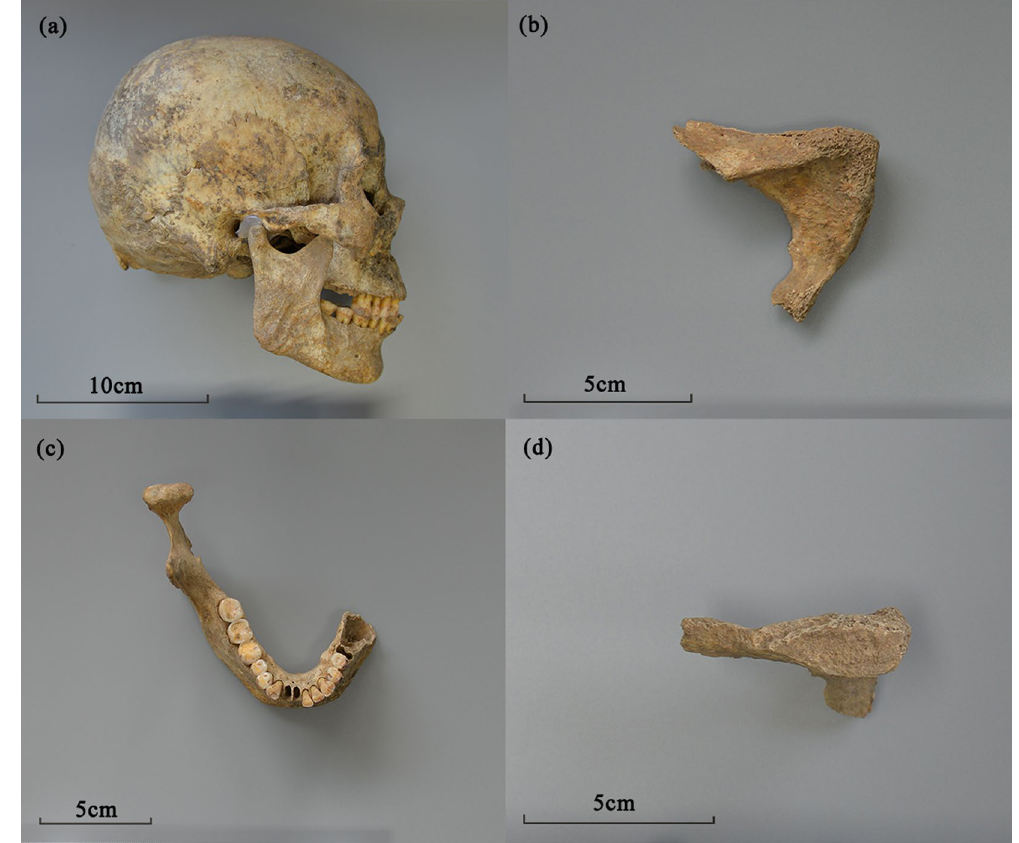
Figure 2. Determination of age and sex ( a ) Skull characteristics; ( b ) Subpubic angle; ( c ) Teeth attrition stage H; ( d ) Pubic symphysis surface phase 5.